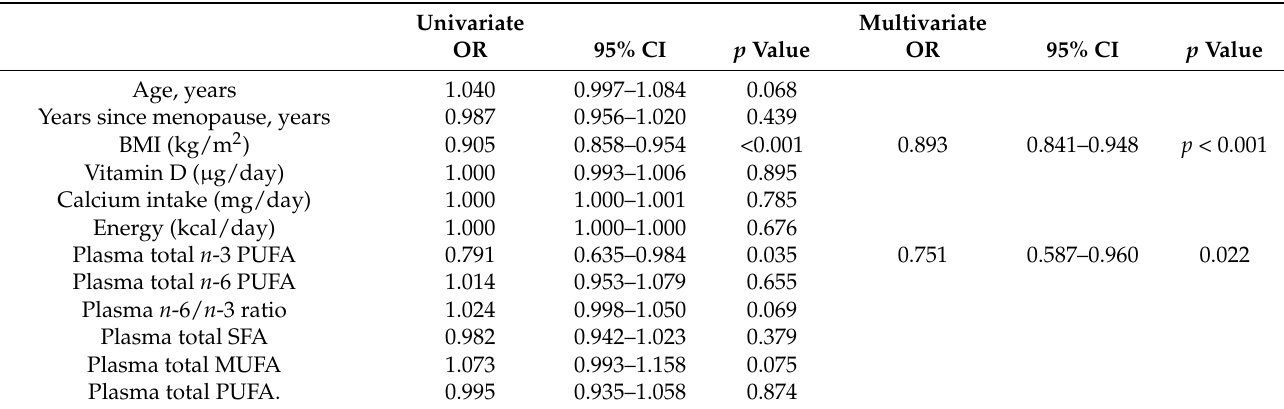
Table 12. Logistic regression of predictors associated with low BMD (T ≤ − 1 score). Univariate Multivariate OR 95% CI p Value OR 95% CI p